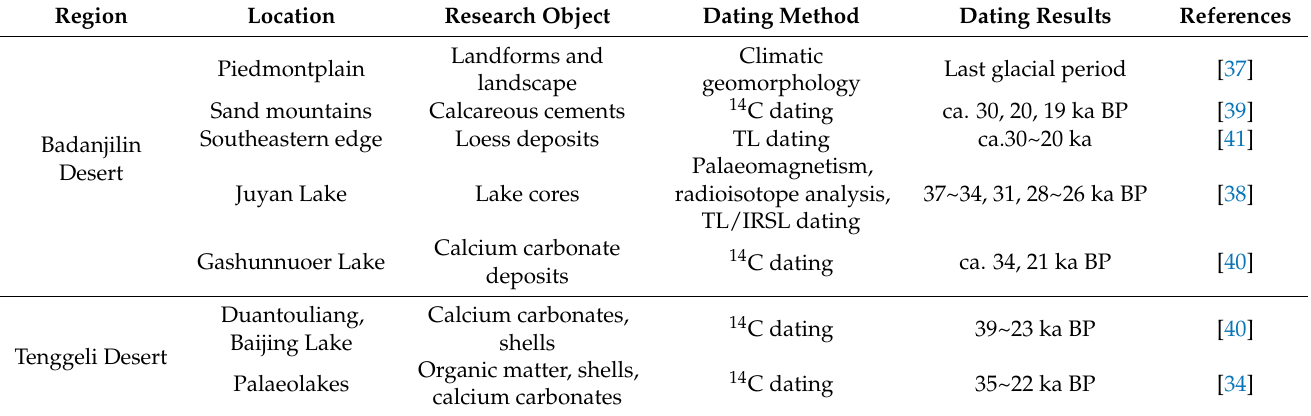
Table 1. A study of the environmental wetness between 40 ka and the end of the Pleistocene on the Alashan